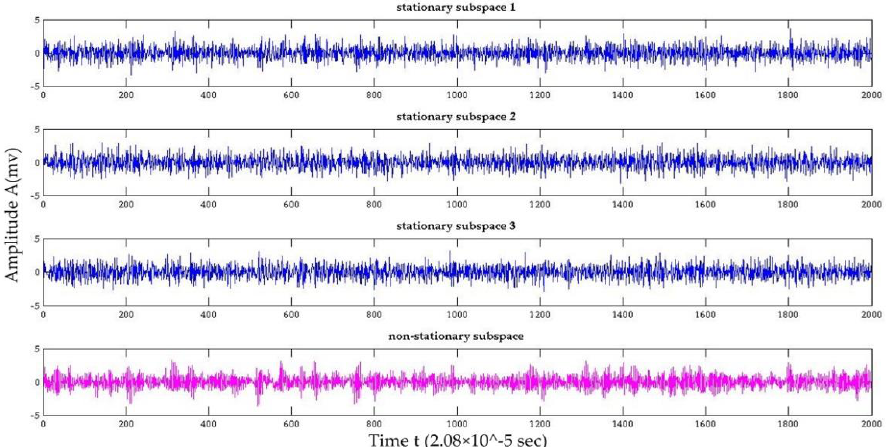
Figure 5. SSA results of normal tool sample.